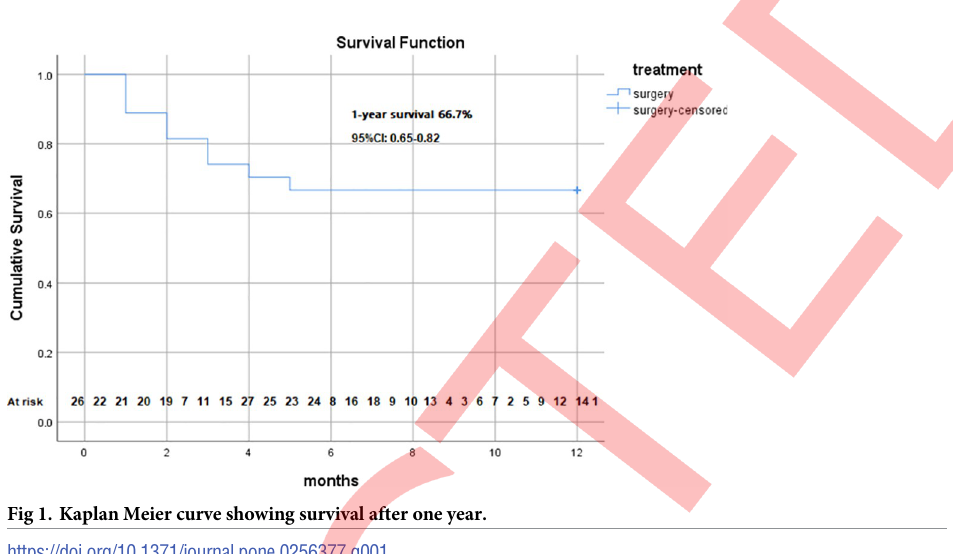
Fig 1. Kaplan Meier curve showing survival after one